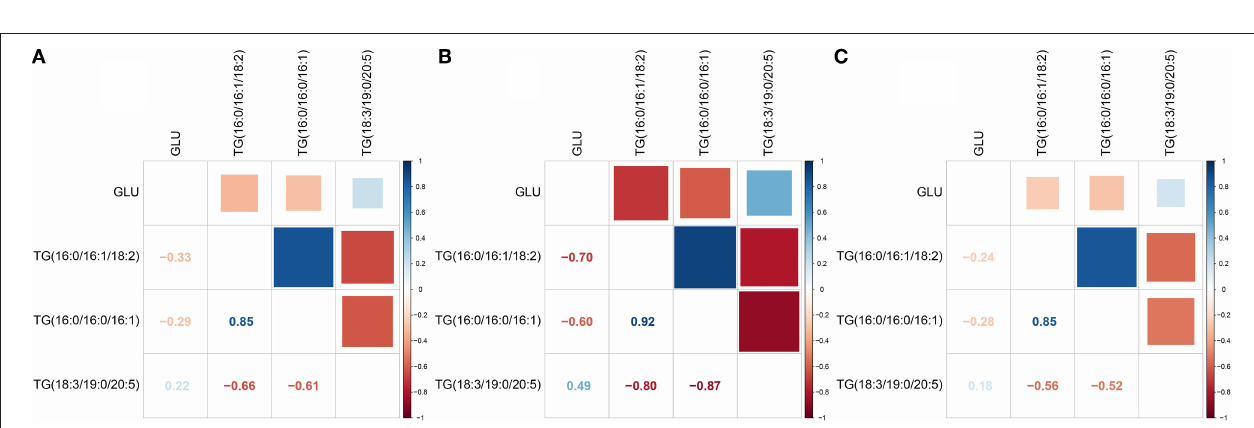
FIGURE 8 | Correlation analysis between TGs and blood glucose (GLU). (A) Correlation analysis of the rice diet group at stage 1 (R1) vs. the control group at stage 1 (C1). (B) Correlation analysis of the flour diet group at stage 1 (F1) vs. C1 at stage 1. (C) Correlation analysis of the rice diet group at stage 2 (R2) vs. the control group at stage 2 (C2). The figures in the picture refer to the correlation coefficient. The positive value of blue is positively correlated, and the negative value of red is negatively correlated.